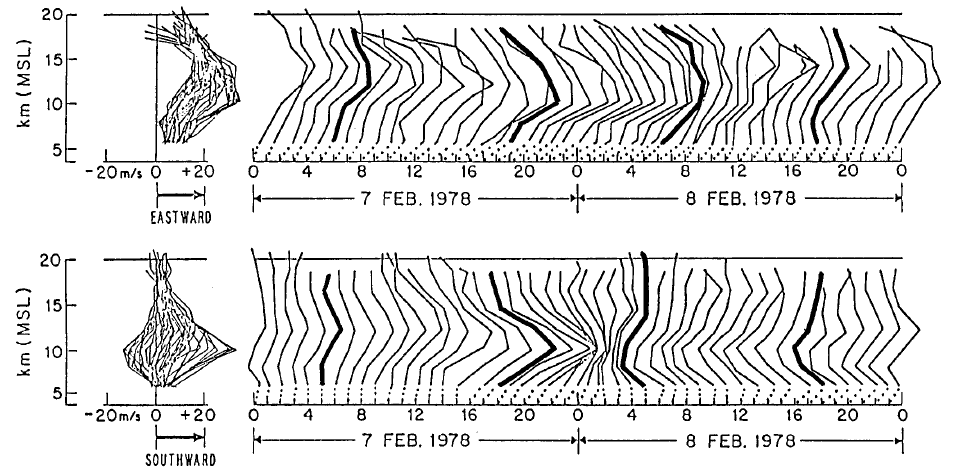
Fig. 7. Hourly-averaged wind profiles observed by the Platte- ville radar on 7–8 February, 1978. The velocity scale appears be- neath the composite set of profiles to the left of the main panel . The time of each profile is indicated by the dotted line below each profile . Darkened profiles corre- spond to the times of the routine National Weather Service radio- sonde ascents from Denver (from Ecklund et al ., 1979)